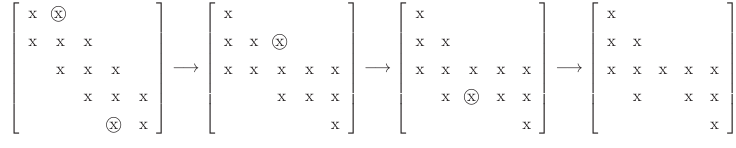
Figure 4. The twisted Q Figure 3.2: Twisted Q Factorization at k = 3 (the next elements to be annihilated are circled): forming N k .